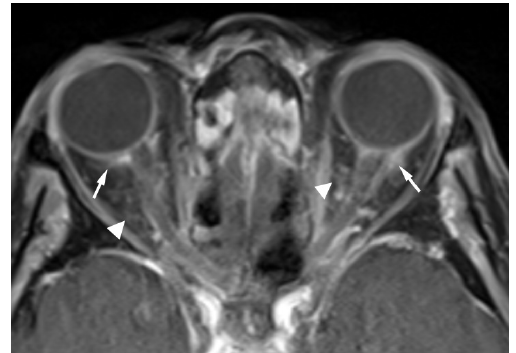
Figure 1: Post-Gd axial T1-weighted MR image with fat saturation shows enhancement of bilateral posterior sclera extending to the adjacent optic nerve sheath (arrows); findings are consistent with scleritis. Also noted is mild ill-defined enhancement in retro-conal fat (arrowheads), consistent with mild post-septal